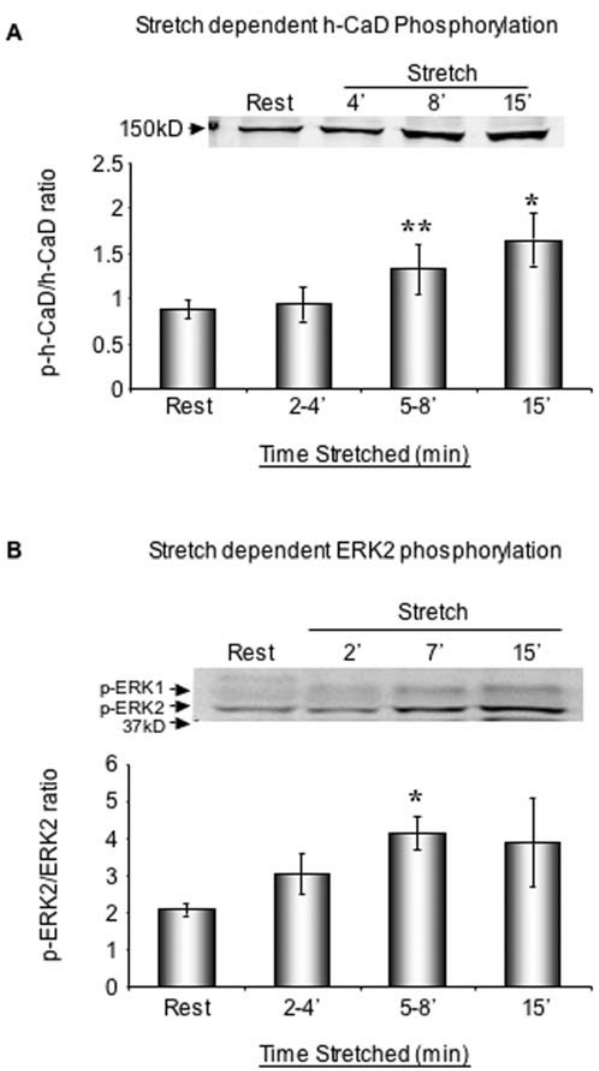
Figure 2. Stretch of human myometrium directly increases h- CaD and ERK phosphorylation. A. h-CaD phosphorylation increases in response to stretch. Phosphorylated p- h -CaD is normalized to h- CaD protein level. *p , 0.05 and ** p=0.01 compared to resting sample (by ANOVA). n=4 samples in each group. B. Stretch increases ERK2 phosphorylation. p-ERK2 signals are normalized to the total ERK2 protein levels. *p , 0.05 compared to resting samples (by ANOVA). n=4–5 samples in each